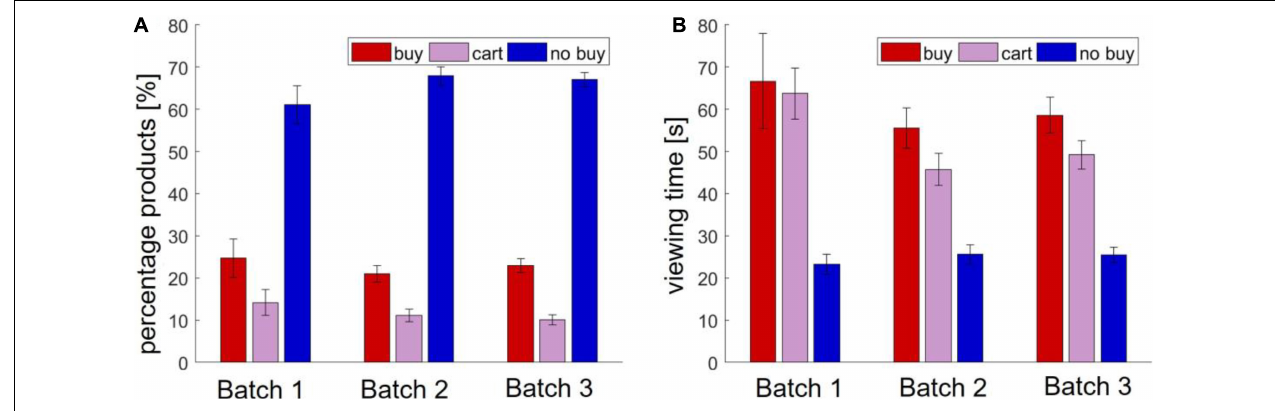
FIGURE 1 | Behavioral results in Study 1. (A) Number of viewed and bought products (B) viewing time.